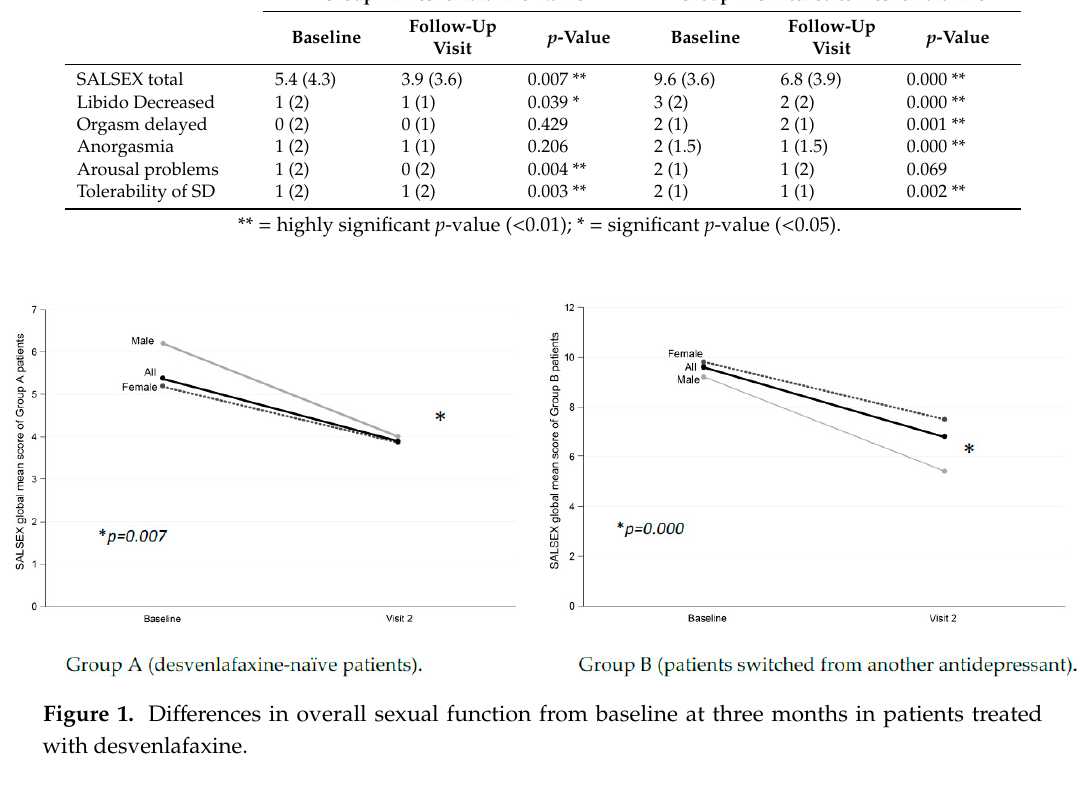
Figure 2. Differences in sexual level of severity from baseline at three months in patients treated with desvenlafaxine.